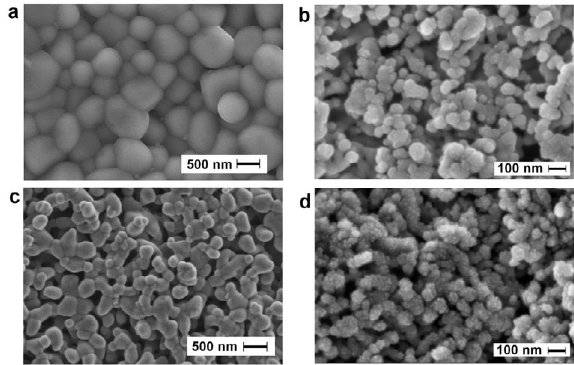
Fig. 6 Representative micrographs of CCTO specimens processed in this work. (a) Fast O3S processing under E = 30 V·cm − 1 , with a current density limit of J = 42.0 mA·mm − 2 (point (e) in Fig. 2(a)); (b) fast synthesis under E = 30 V·cm − 1 , at which instance the specimen reached a current density of J = 4.1 mA·mm − 2 (point (c) in Fig. 2(a)); (c) and (d) flash synthesis under E = 200 V·cm − 1 for current density limits of J = 22.0 and 7.5 mA·mm − 2 , respectively (points (f) and (g) in Fig. 2(a)). The dwell time at the current limits was 1 min. The two last images (c) and (d) are reproduced with permission from Ref. [36], © The Royal Society of Chemistry 2016.